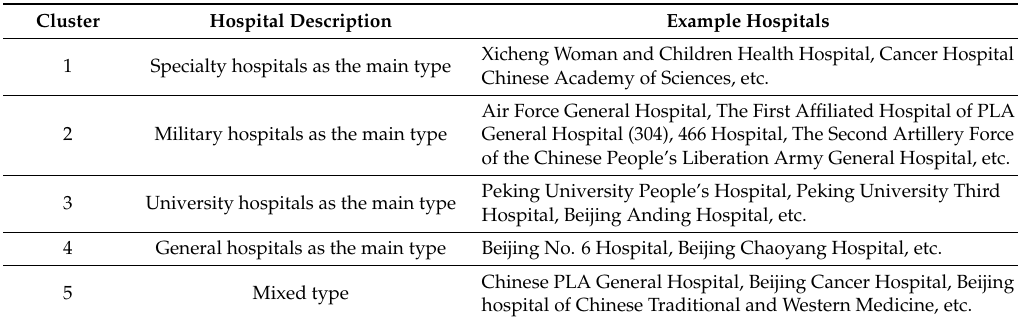
Table 1. Classification results of